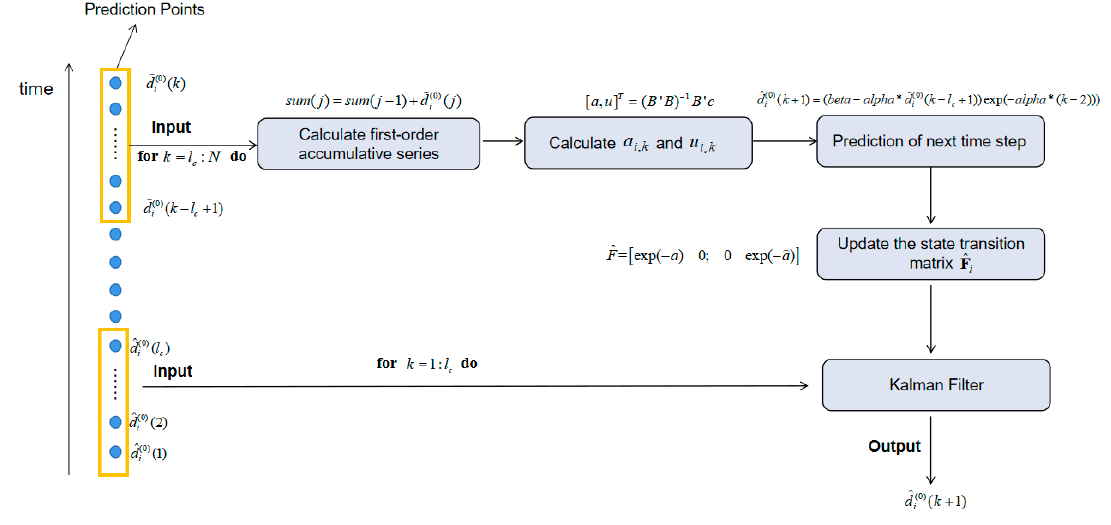
Figure 2. The flowchart of GKF.